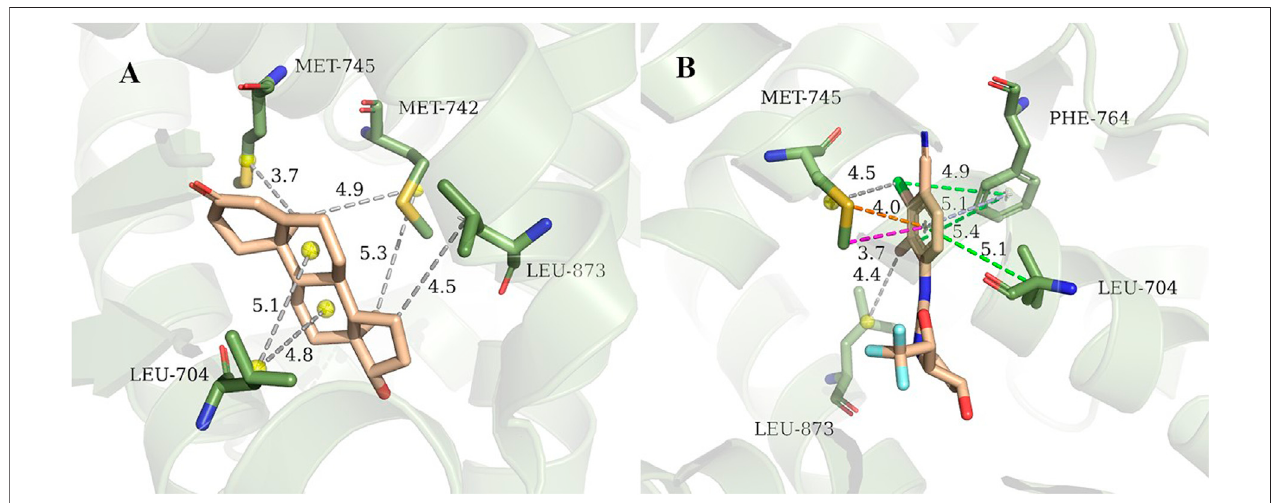
FIGURE3| Interactiondiagramof1i37(Sacketal.,2001) (A) and3g0w(Nirschletal.,2009) (B) .Thegraylinesrepresentthealkylinteraction,greenlinesdenotePi- Alkyl interaction, light blue lines denote Pi-Pi interactions, orange lines denote Pi-Sulfur interactions and magenta lines denote Pi-Sigma interactions.